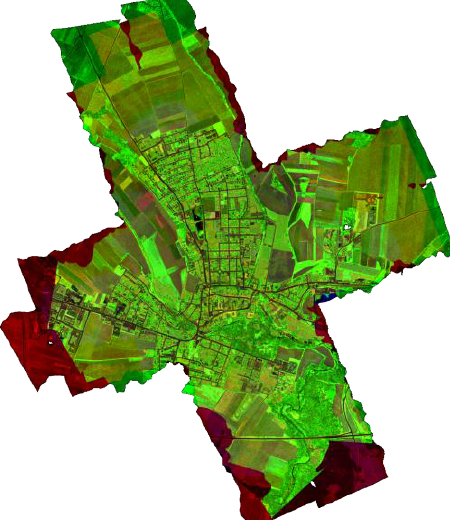
Figure 6. Active multi-wavelength reflectance image estimated from radiometrically calibrated ALS data sets; 532nm (linear scale from 0 (black) to 1 (blue)); 1064nm (linear scale from 0 (black) to 1 (green)) and 1550nm (linear scale from 0 (black) to 1 (red)).